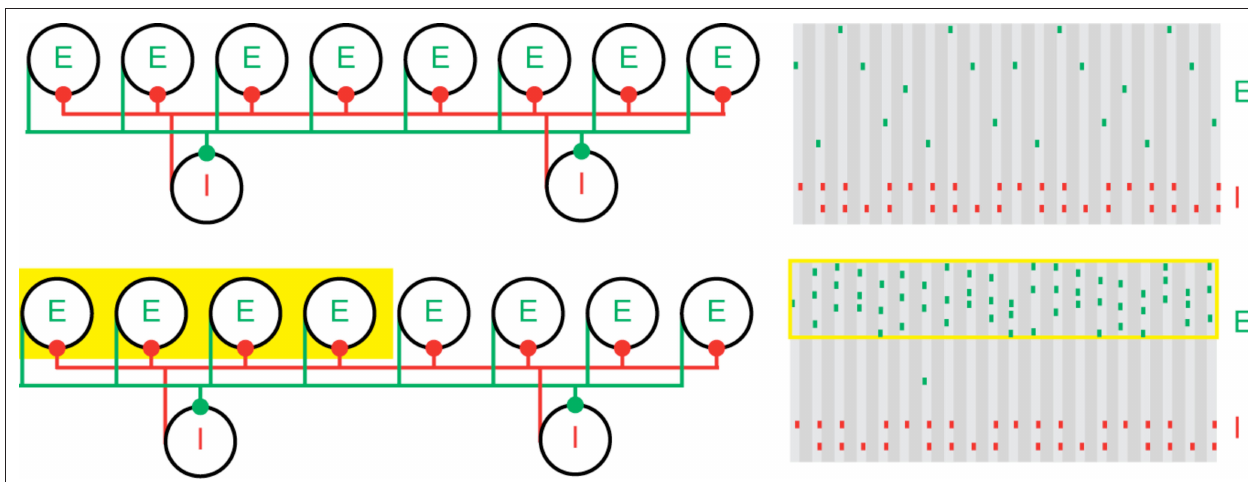
(red) cell. In each cycle of the persistent gamma rhythm, a single pyramidal cell spikes and delivers excitation to the FS cells. The FS cells then spike and inhibit the pyramidal cells. When the inhibition decays sufficiently, one of the pyramidal cells generates another spike, and the rhythm continues. Lower : Increased depolarizing input to a subset of pyramidal cells (yellow box on the left) increases their spiking activity. The population gamma rhythm continues with the “driven” pyramidal cells (yellow box on the right) dominating the excitatory